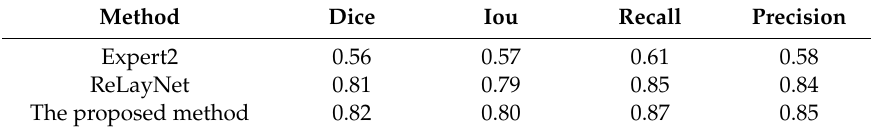
Table 3. Quantitative comparison of segmentation results around fovea edema regions.